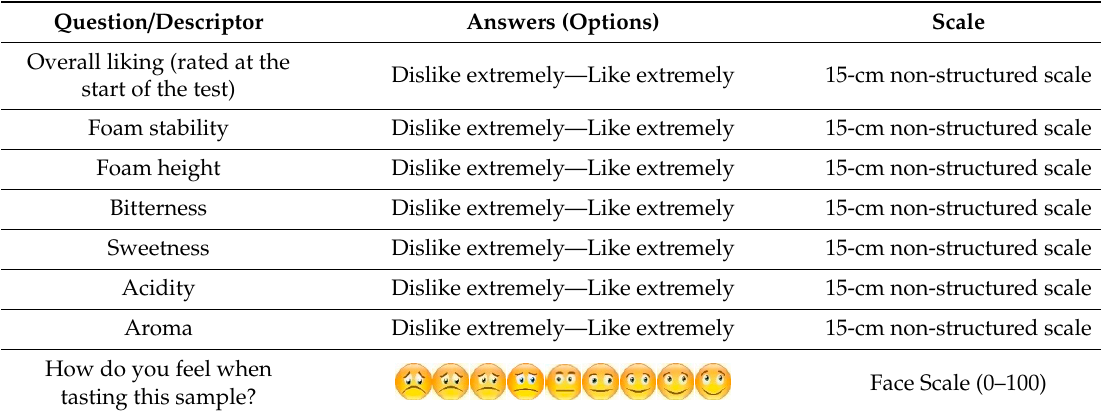
Table 2. Questionnaire presented in the Bio-Sensory